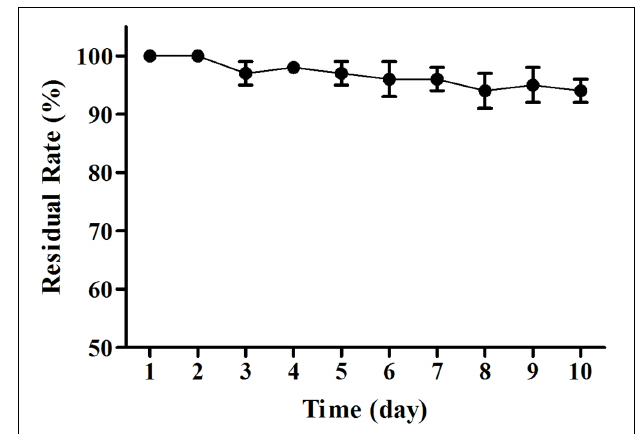
FIGURE 9 | UV resistance test. The activities of lipopeptides retained above 94% after 10 days under UV exposure.